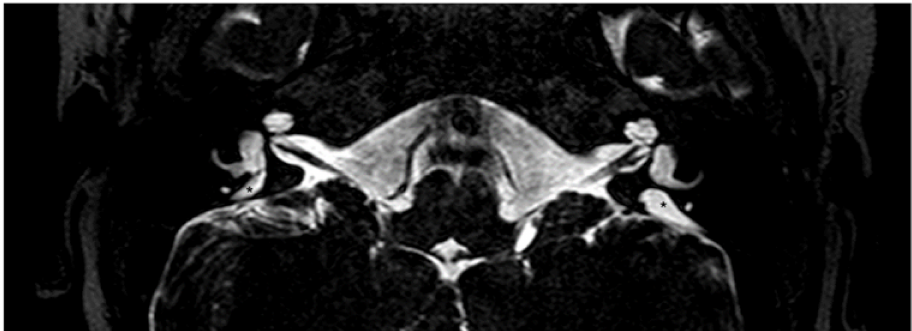
Figure 3. Magnetic resonance imaging of the temporal bones of the same patient shown in Figure 2, T2-weighted. A bilaterally enlarged endolymphatic duct can be observed. *, enlarged endolymphatic